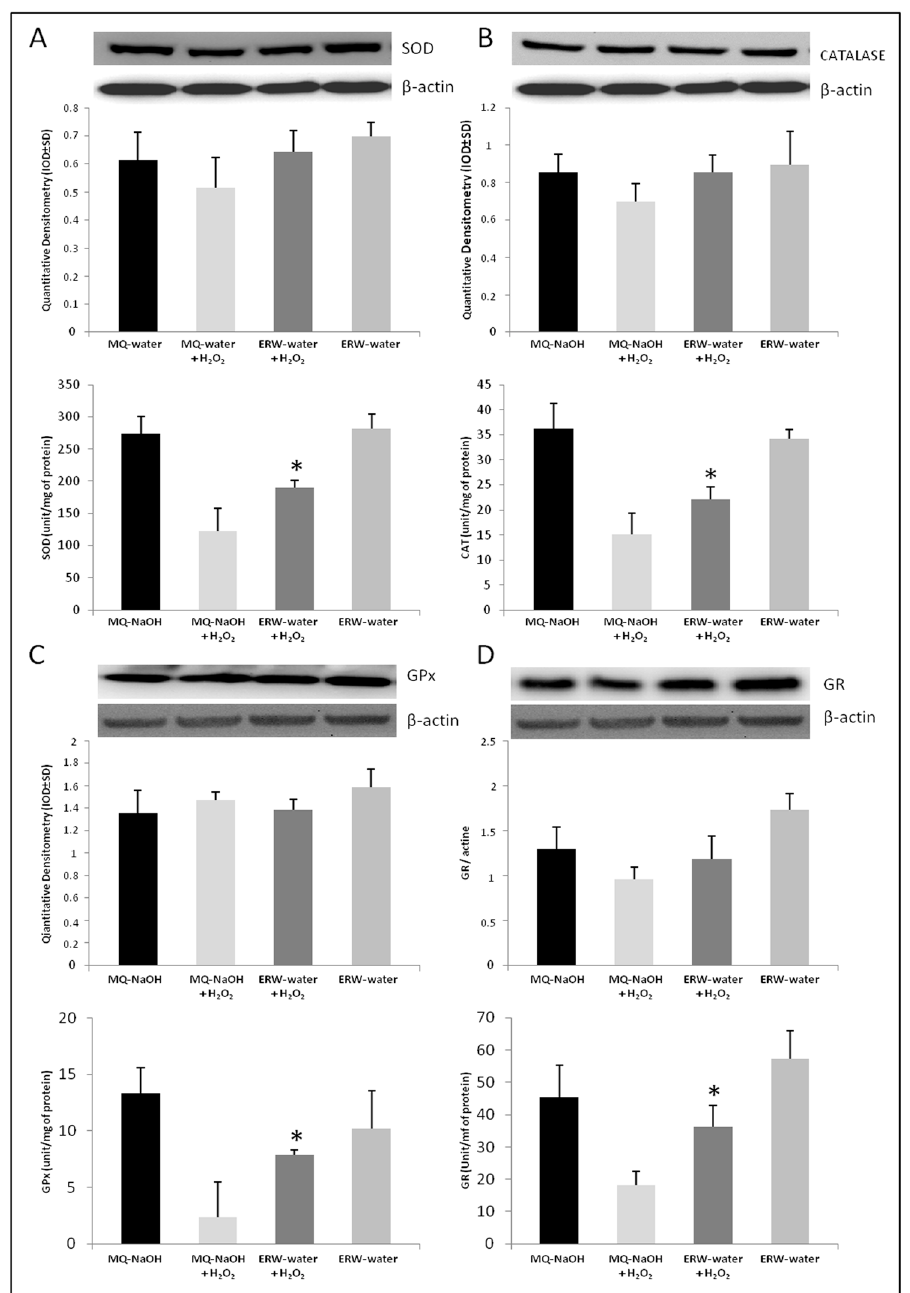
Figure 3. Effect of an ERW medium on the protein expression ( top ) and activity ( bottom ) of antioxidant enzyme SOD ( A ); CAT ( B ); GPx ( C ); and GR ( D ). * p < 0.05 vs. MQ-NaOH + H 2 O 2 . Data is presented as means ± SD for triplicate experiments.